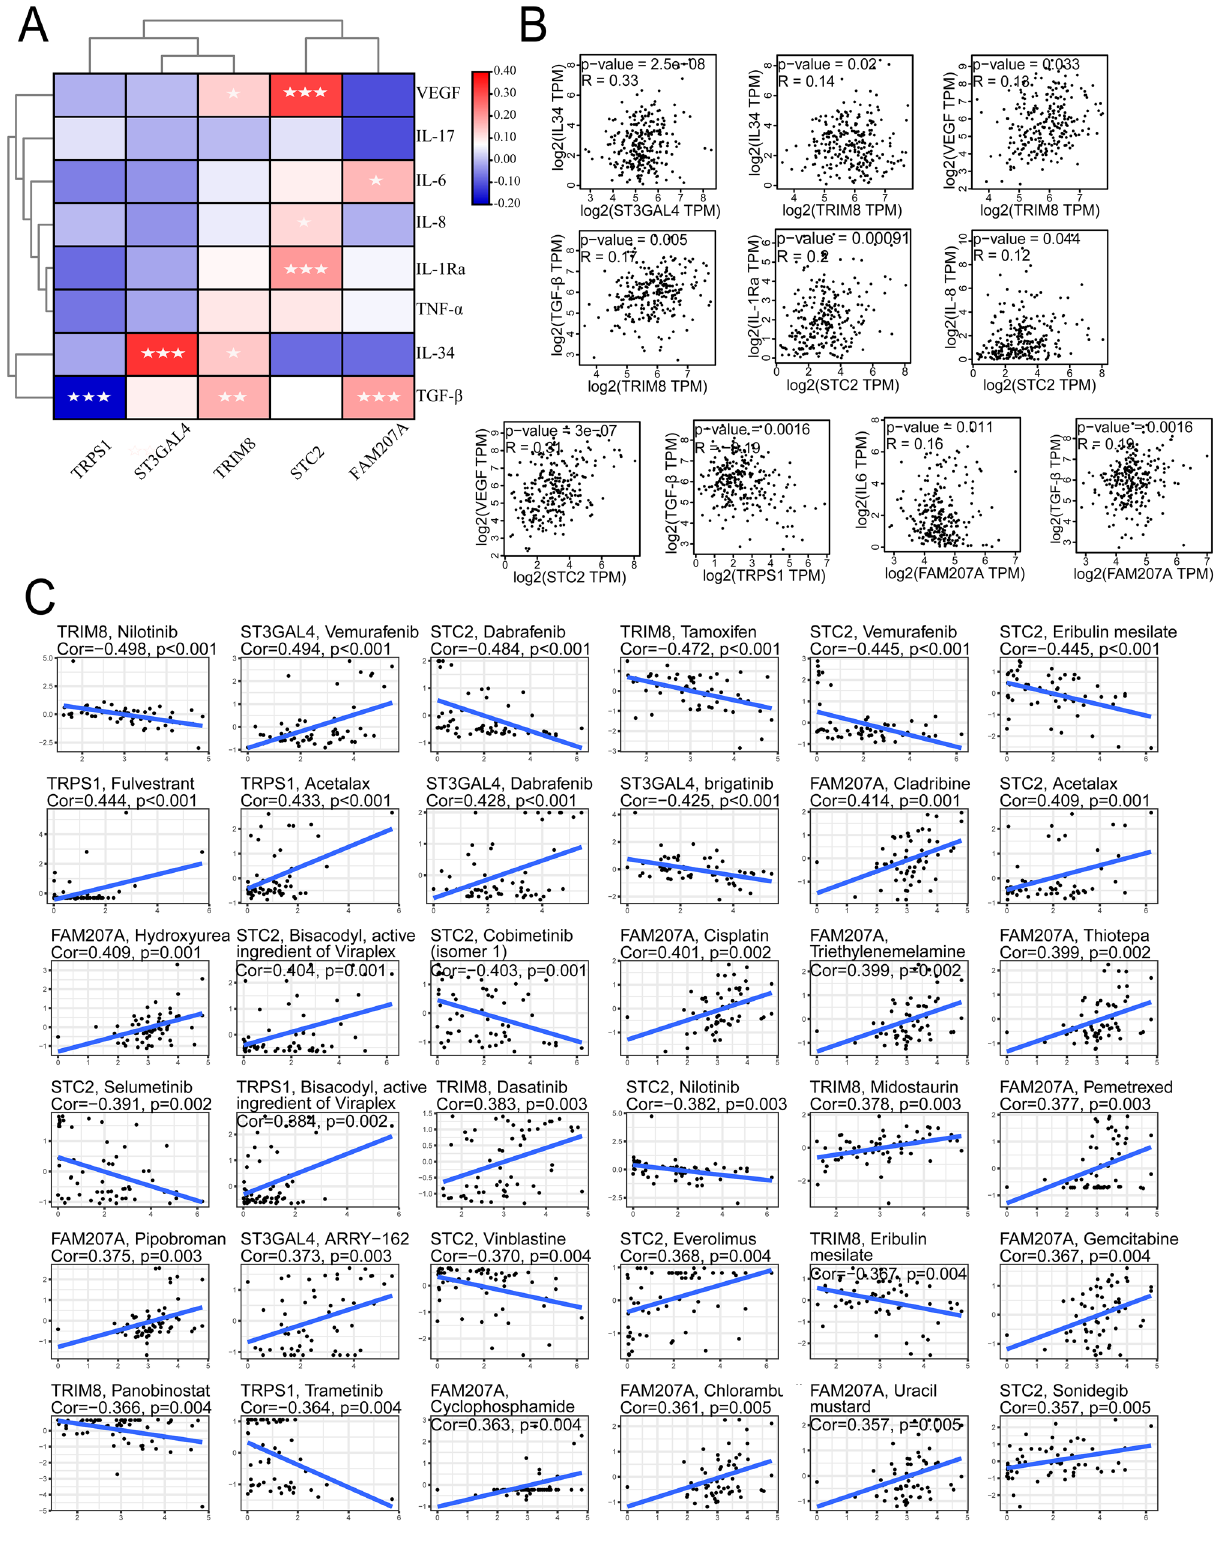
Figure 6. Correlation analysis of osteosarcoma-related cytokines and drug sensitivity analysis of five genes. ( A ) Heat map of the correlations between the five genes and osteosarcoma-associated cytokines, where red represents positive correlations and blue represents negative correlations. ( B ) The statistically significant correlation plots from the correlation analysis of the five genes and osteosarcoma-associated cytokines. ( C ) The drug sensitivity analysis of the five genes. "Cor value > 0" indicates that the gene is positively correlated with the sensitivity of the drug, and "Cor value < 0" indicates that the gene is negatively correlated with the sensitivity of the drug. When the relationship is positive, a higher expression value of the gene indicates stronger sensitivity of the corresponding drug. For a negative correlation, a higher gene expression value indicates weaker sensitivity of the corresponding drug. (" * " represents P < 0.05, " ** " represents P < 0.01, and " *** " represents P <